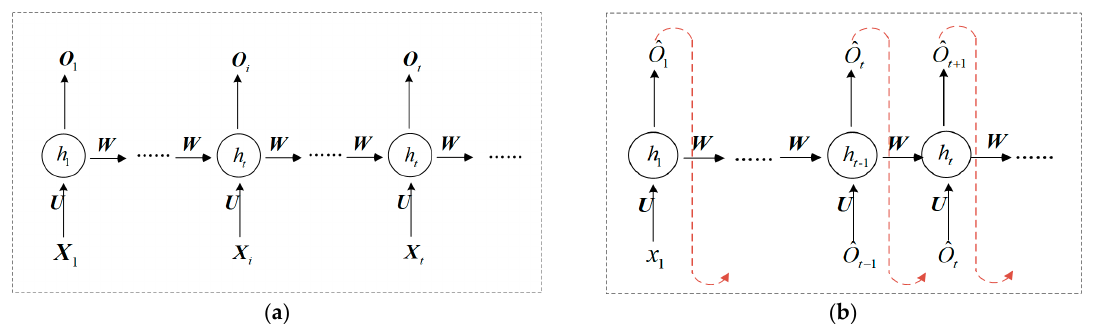
Figure 2. RNN expansion model based on time series: ( a ) the learning stage of the RNN model; ( b ) the generation stage of the RNN model.